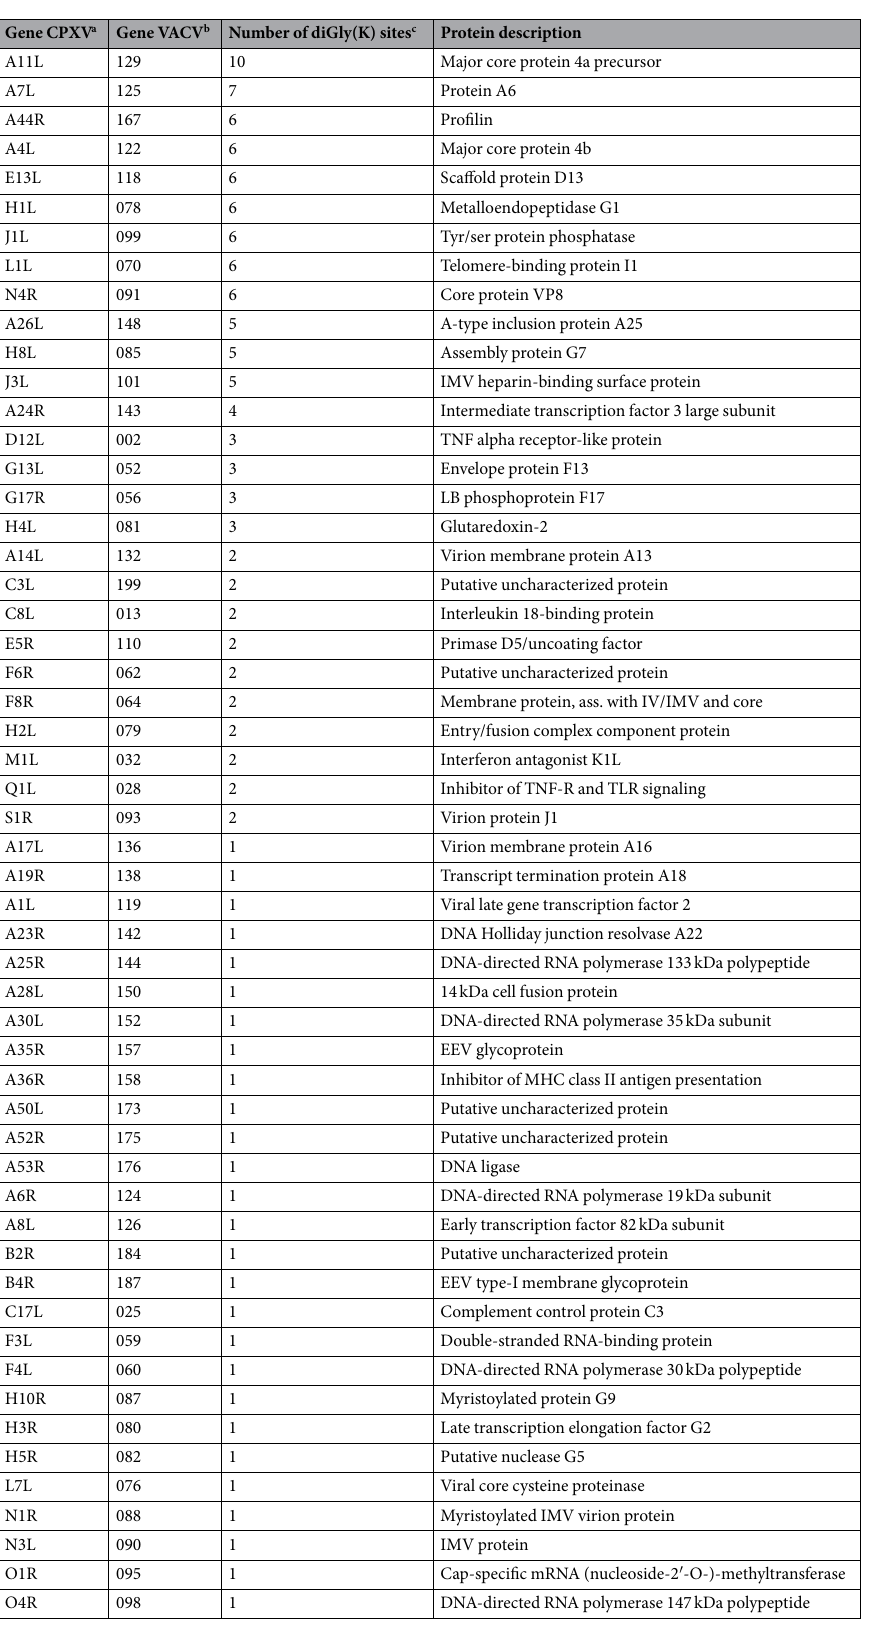
Table 2. CPXV mature virion proteins with conserved ubiquitination sites. a according to CPXV GRI-90. b according to VACV WR. c conserved in five analyzed CPXV